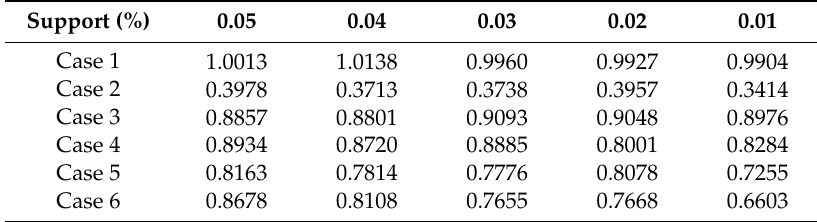
Figure 3. E ff ect of varying support from 0.01% to 0.05% on proportions of execution time in FDCNB-MINING and FLR-mining. Table 3. Proportions of execution time for FDCNB-MINING / FLR-mining while varying support from 0.01% to 0.05% and Case1 to Case